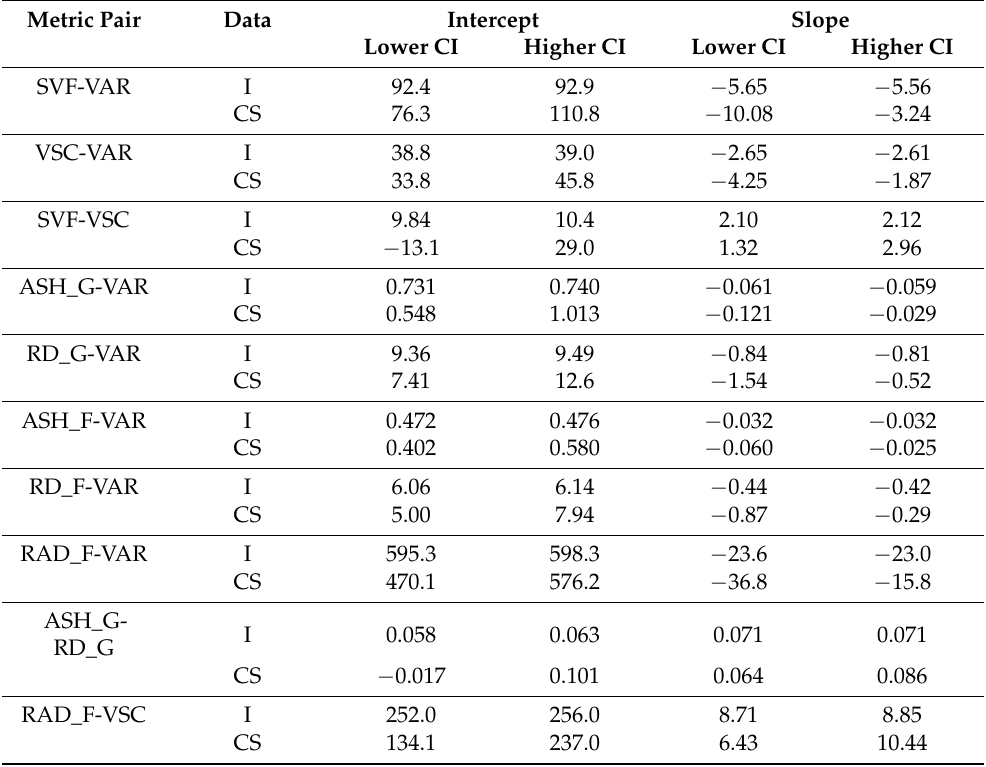
Table 4. Confidence intervals (CIs) of 95% level for linear regression model coefficients of iteration- (I) and case study- (CS) based metric datasets. A metric pair is validated when CI for I data fits within the CI of CS data.